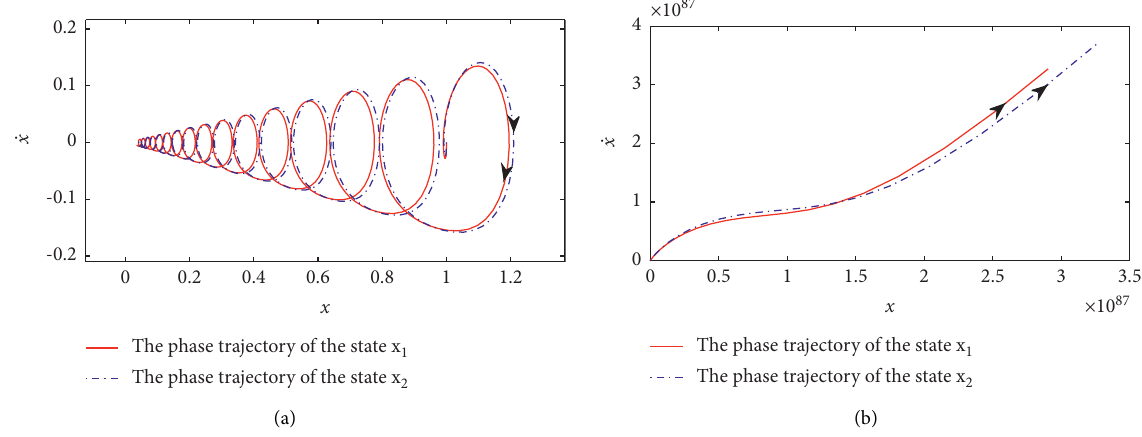
Figure 8: The phase portrait of a 2-DOF system with different nonlinearities in the feedback path. (a) The phase trajectory with the selected values in the stable ranges. (b) The phase trajectory with the selected values out of the stable